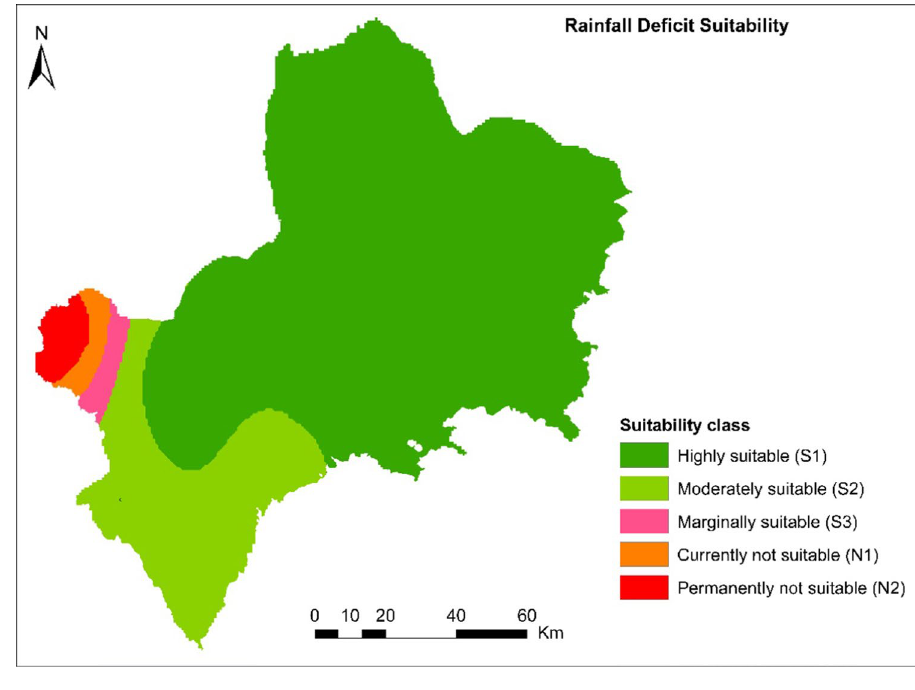
Fig. 12 Rainfall deficit suit- ability map